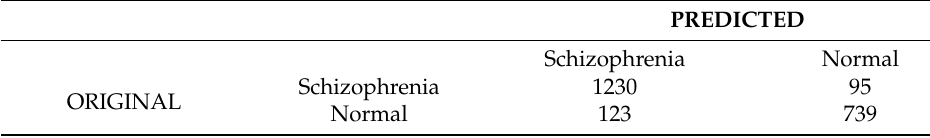
Table 1. EEG Recurrence Plot confusion matrix.